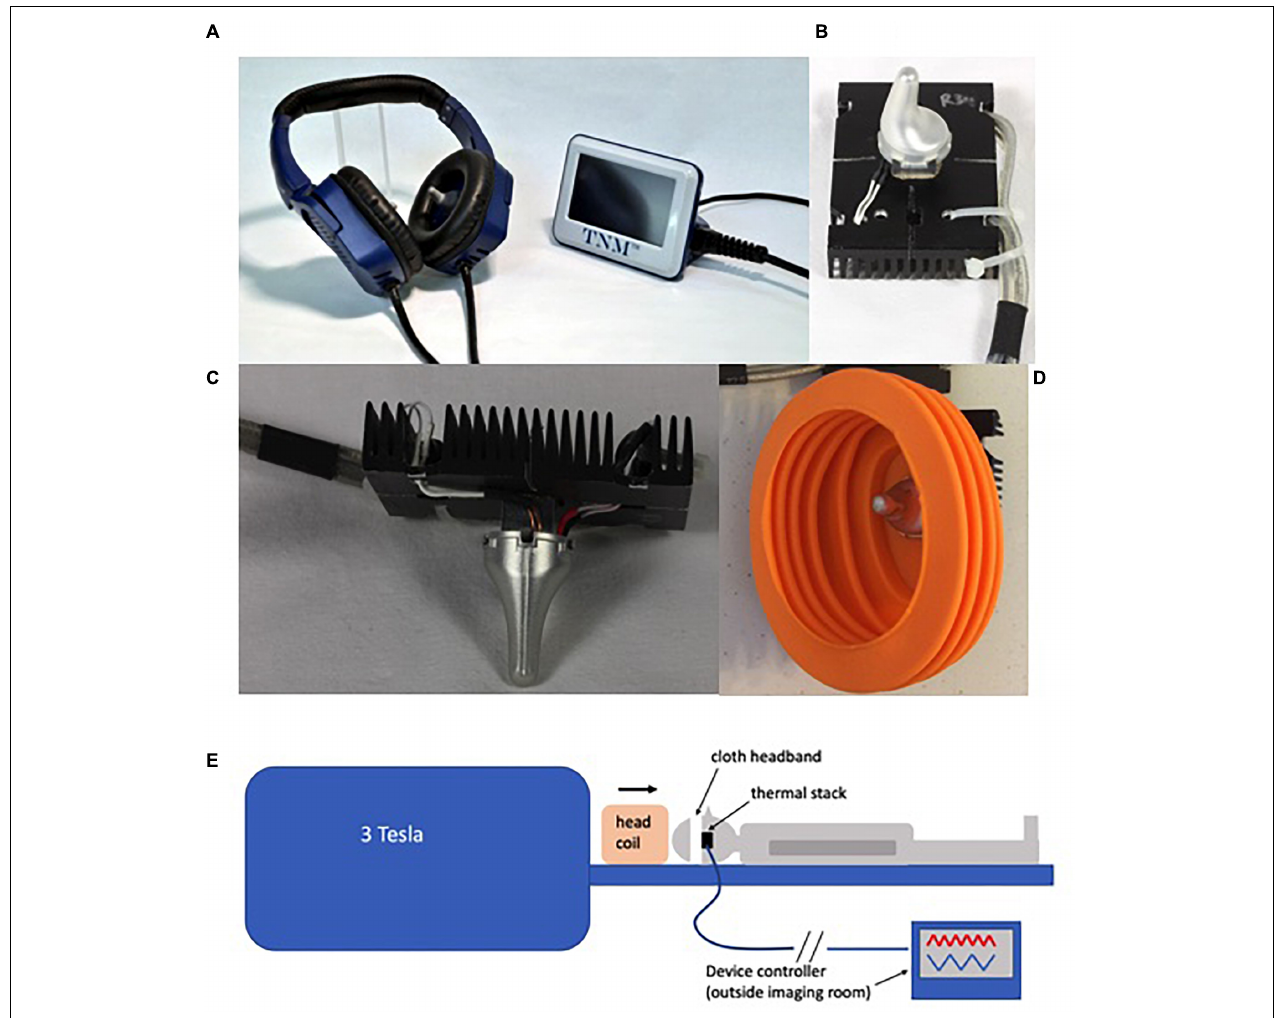
FIGURE 1 | (A) A tvCVS device (Scion NeuroStim, Durham, NC); (B) The earpiece/Peltier device/heat sink thermal stack; (C) Side view of the thermal stack; (D) A baffle used to reduce acoustic noise during the BOLD scan; (E) A schematic showing the environment of the imaging